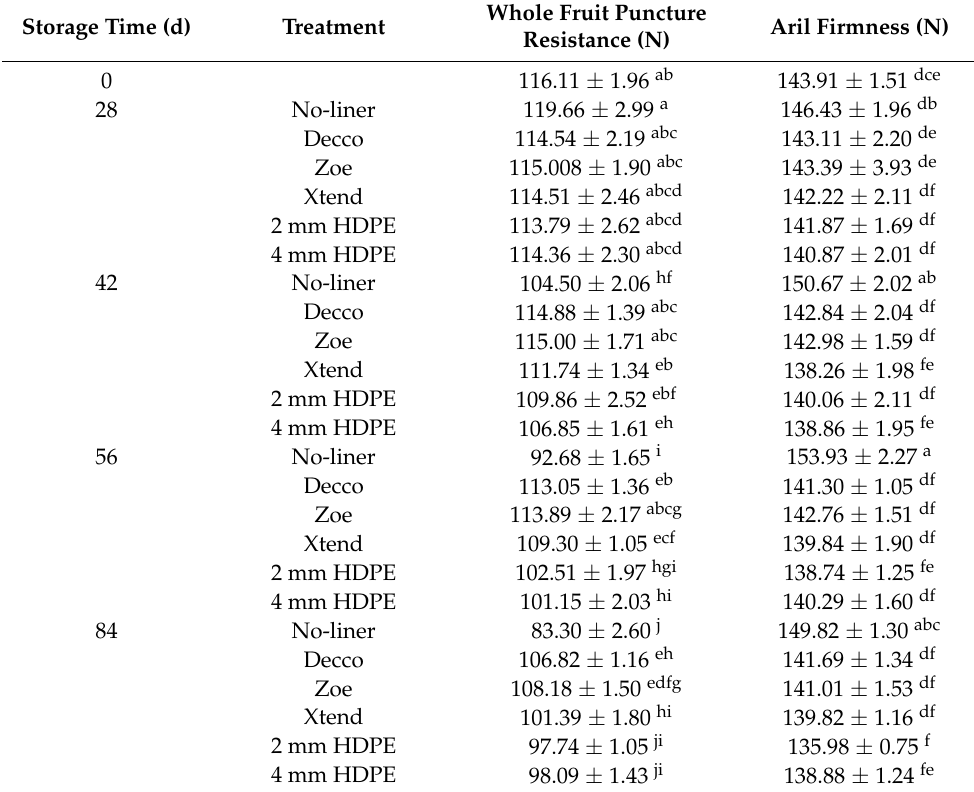
Table 4. Whole fruit puncture resistance and aril firmness for pomegranate fruit packed in different liner bags for 84 d at 5 ◦ C and 90% relative humidity